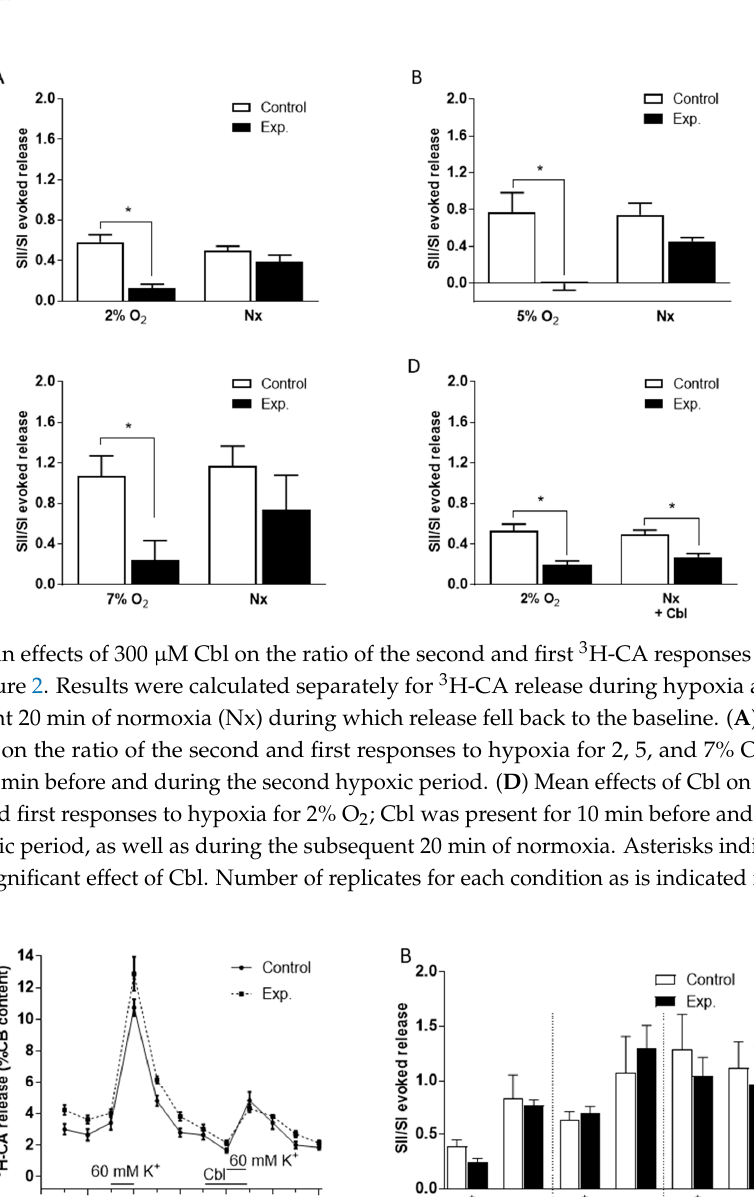
Figure 4. Effects of Cbl on the 3 H-CA release response elicited by three elevated levels of extracellular K + . ( A ) The continuous line in shows the effects on catecholamine release of successive exposures of CBs (at 30–40 min, SI, and 80–90 min, SII) to 60 mM K + (n = 5 in each condition) under control